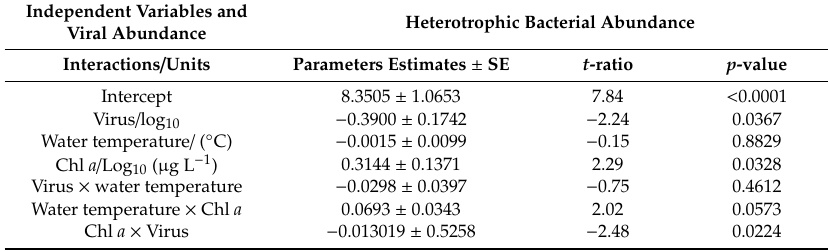
Table 2. Multiple linear regression test model showing the interactions among the environmental parameters (Water temperature and chl a concentration) and viral abundance with heterotrophic bacterial abundance.